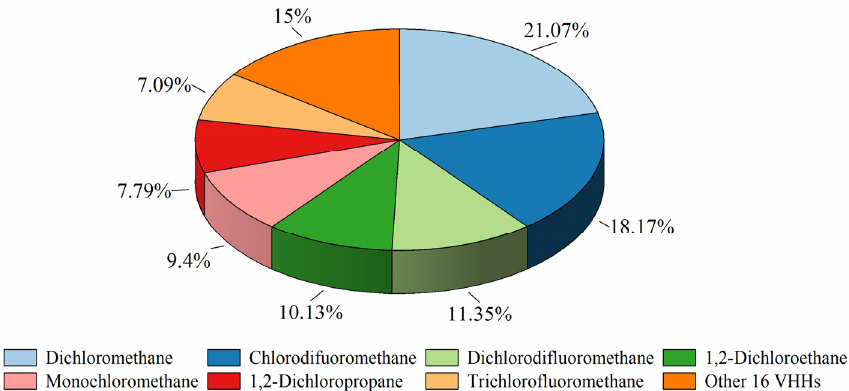
Figure 3. Composition of atmospheric volatile halogenated hydrocarbons (VHHs) at the study site with respect to dominant chemical species.